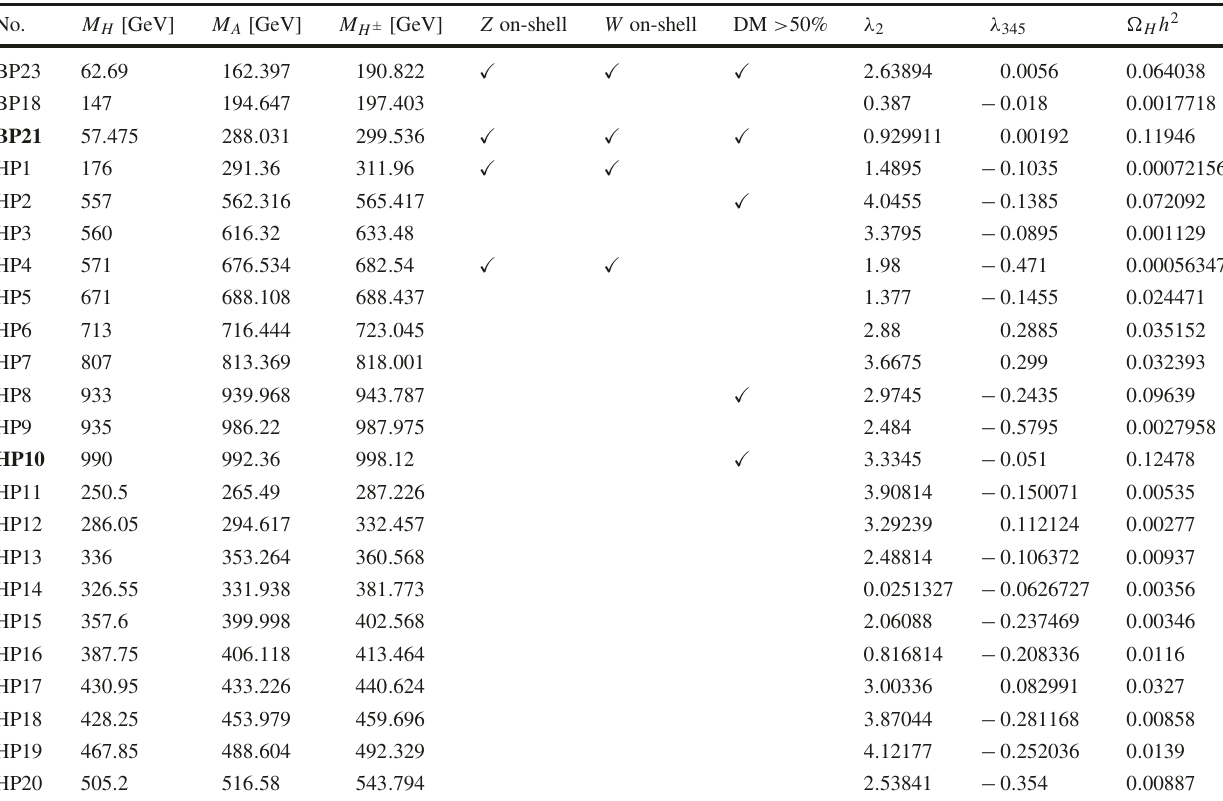
125 . 1GeV for all points. =